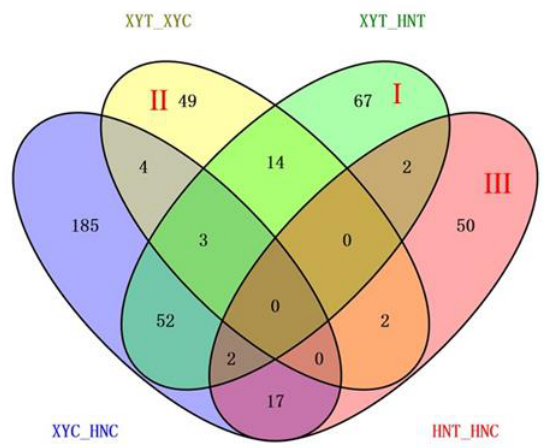
Figure 3. Venn diagram analysis of DAPs identified in the four experimental comparisons. Each compared combination is separated by an underscore (e.g., XYT_XYC, the former is divided by the latter).